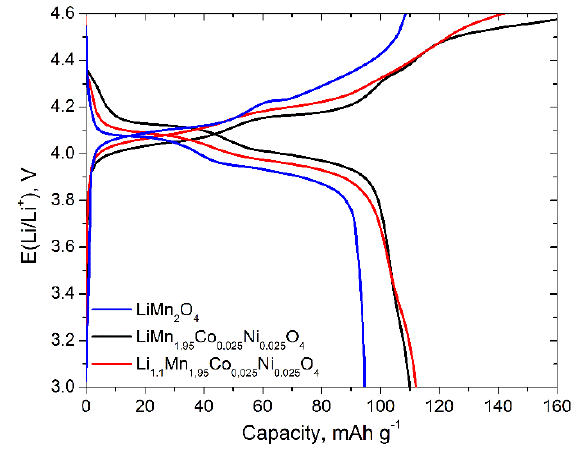
Figure 7. Galvanostatic charge-discharge curves for LiMn 1.95 Co 0.025 Ni 0.025 O 4 , Li 1.1 Mn 1.95 Co 0.025 Ni 0.025 O 4 and LiMn 2 O 4 at C/5 discharge rate at the first cycle. Potential range during cycling is 3–4.6 V. Galvanostatic curves at different discharge rates for Li 1.1 Mn 1.95 Co 0.025 Ni 0.025 O 4 are represented in Figure 8a. The highest discharge capacity 113 mAh·g −1 was obtained for C/5 discharge rate. The increase in discharge current density led to the fal of the discharge capacity to 95, 75, 55 and 17 mAh·g −1 for discharge rates C/2.5, C, 2 C and 4 C, respectively.